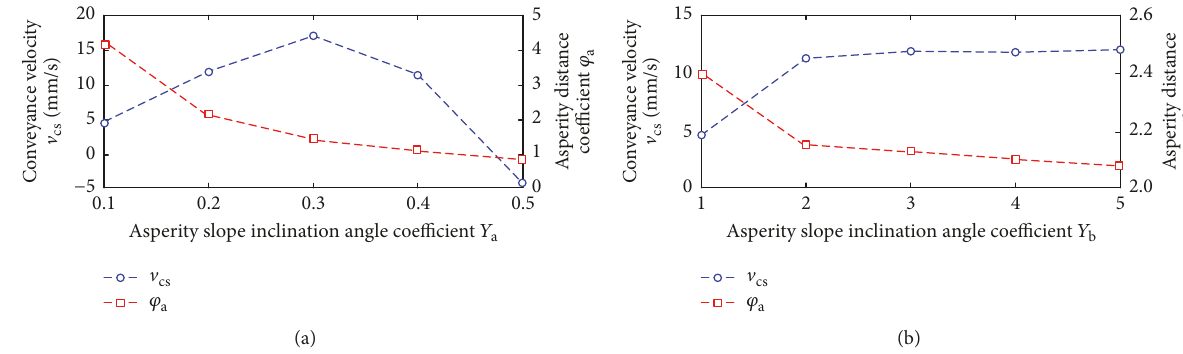
Figure 17: Influence of the asperity slope inclination angle on the conveyance velocity and the distance between two asperities. (a) Influence of 𝛼 when 𝑌 h = 0.4 and 𝑌 b = 4 and (b) influence of 𝛽 when 𝑌 h = 0.4 and 𝑌 a = 0.2 .